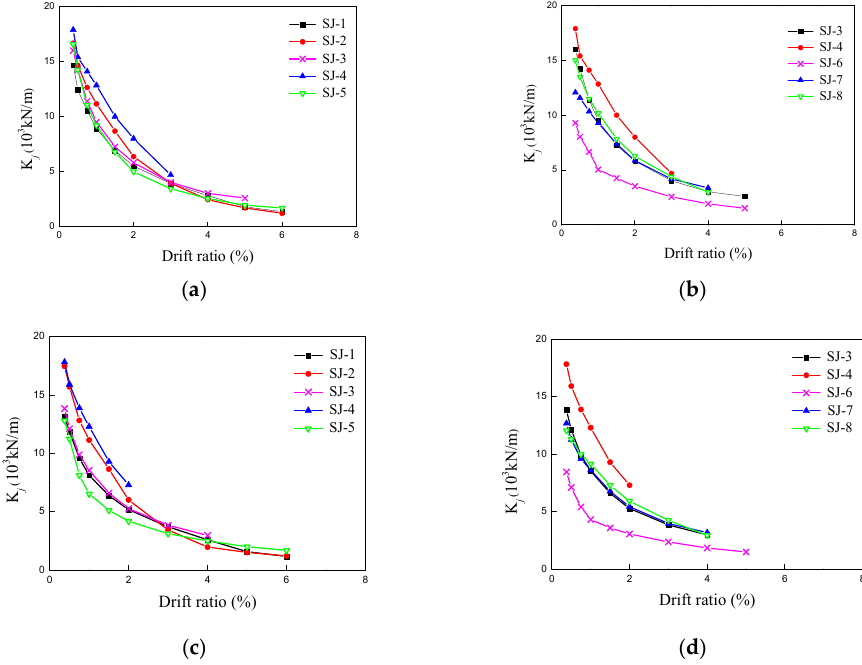
Figure 20. Sti ff ness degradation coe ffi cients: ( a , c ) Positive direction and ( b , d ) Negative